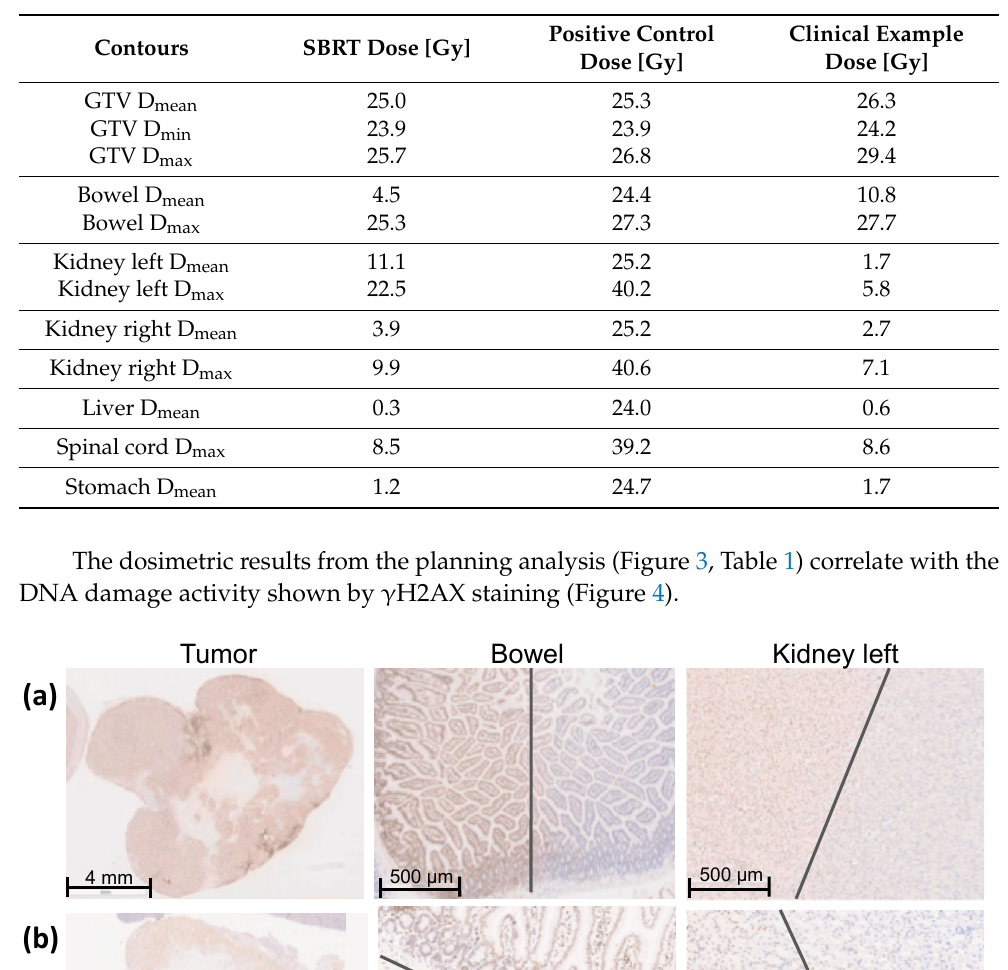
Table 1. Dosimetric analysis of 25 Gy single-dose SBRT in vivo, whole-abdomen irradiation with 25 Gy in vivo, and a clinical example of SBRT with 25 Gy of a PDAC patient including the mean dose (D mean ), the minimum dose (D min ), and the maximum dose (D max ) of the GTV and OARs.